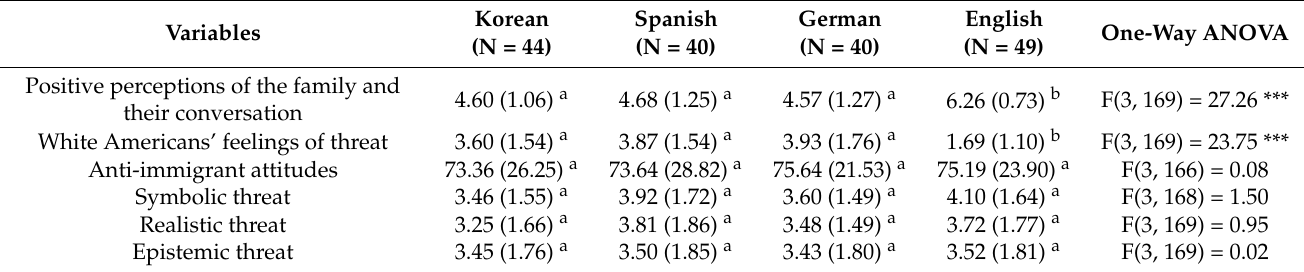
Table 1. Mean scores and standard deviations for the main variables (Study